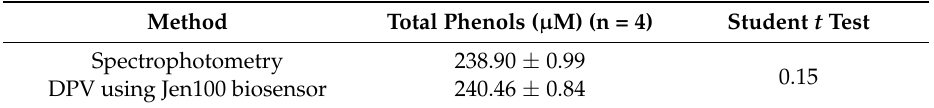
Table 3. Phenolic compounds detected in the industrial effluent sample by CP-Jen100 and spectrophotometry.